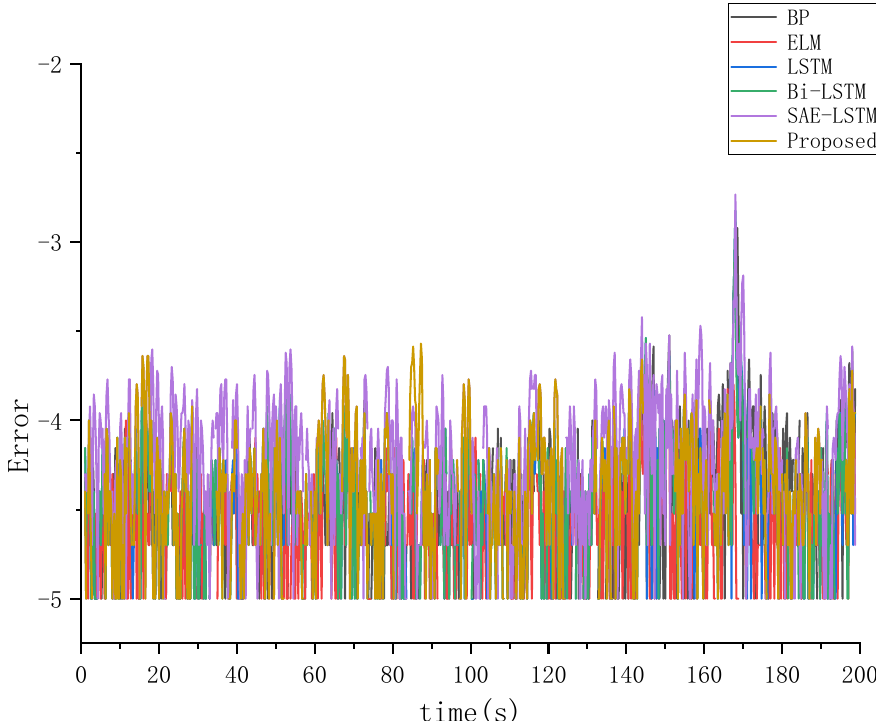
Figure 20. Pitch angle prediction error results in the training set of Dataset